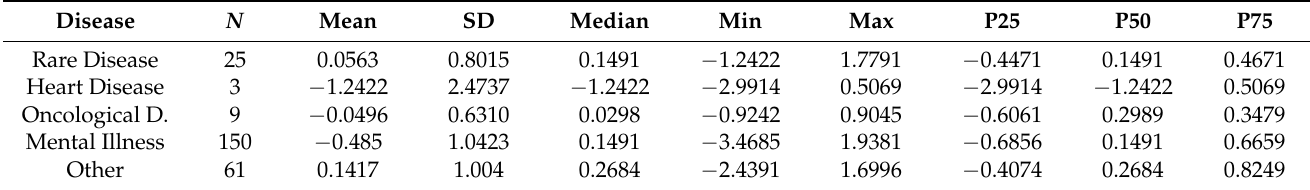
Table 4. Descriptive statistics of the emotional well-being factor according to the disease variable.